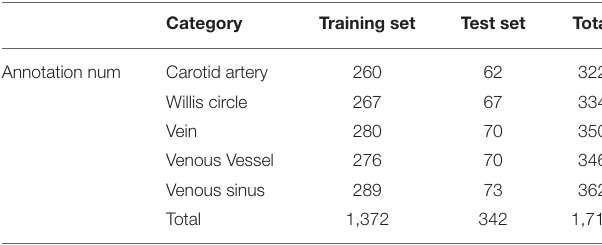
TABLE 2 | Data summary of structures